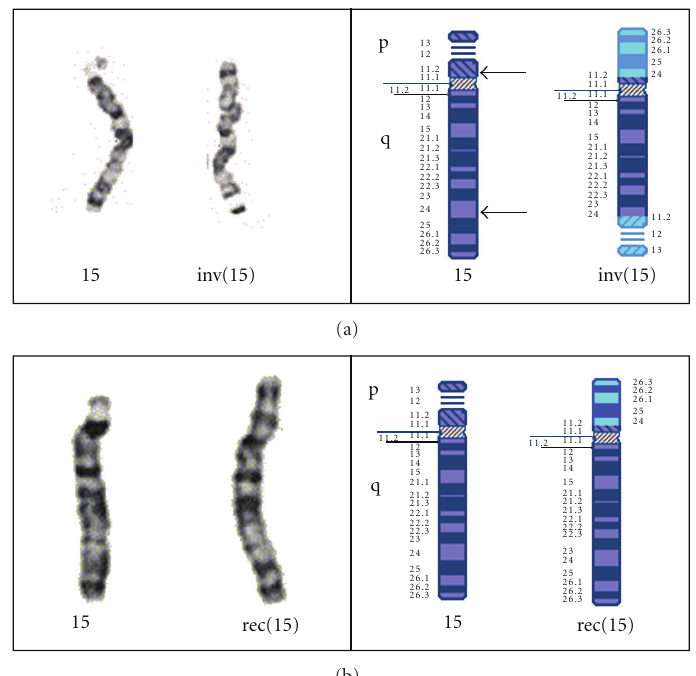
Figure 2: Partial karyotype and ideograms of chromosomes 15 of proband and mother. (a) The mother’s partial karyotype and ideogram shows a normal chromosome 15 (left) and inverted chromosome 15 (right). (b) The proband’s partial karyotype and ideogram shows the normal chromosome 15 (left) and recombinant chromosome 15 (right).